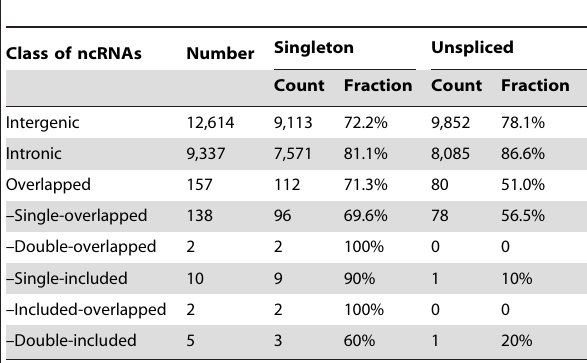
(Figure 7D). The results of the GERP ++ score for the intergenic and intronic ncRNAs, as well as the different intergenic classes were also consistent with their respective phastCons score results (Figure 7E and Figure 7F). When we removed all UTR-related RNAs from 23,060 ncRNAs, the remaining sequences still showed clear conservation compared to un-transcribed control fragments (Figure S2). The highly conserved UTR-related RNAs is consistent with these being part of poorly annotated UTRs or independent transcripts from UTRs, as UTRs across different species are often well conserved (Figure S2). Table 1. Summary of transcriptional redundancy and splicing information of three types of